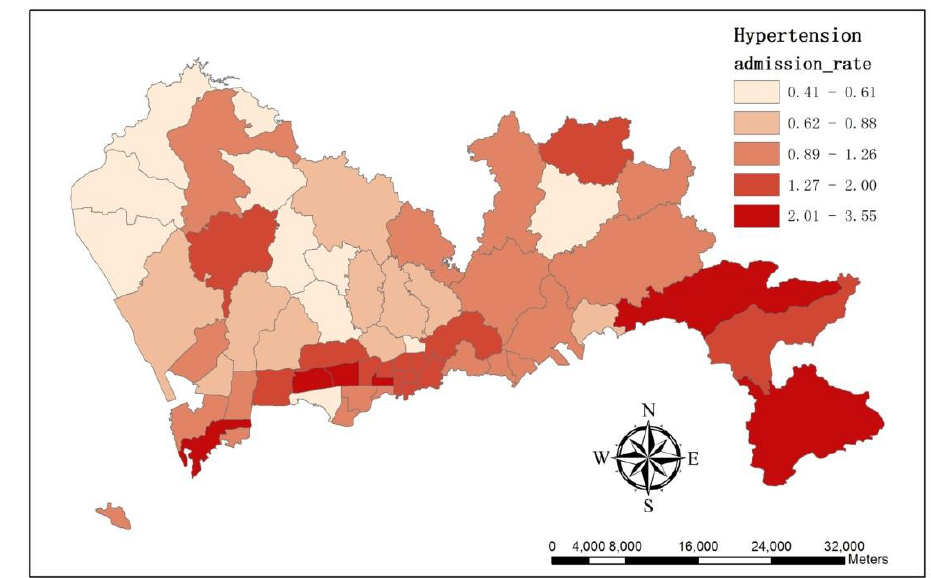
Figure 3. The map illustrates the spatial variation of hypertension admission rate at sub-district